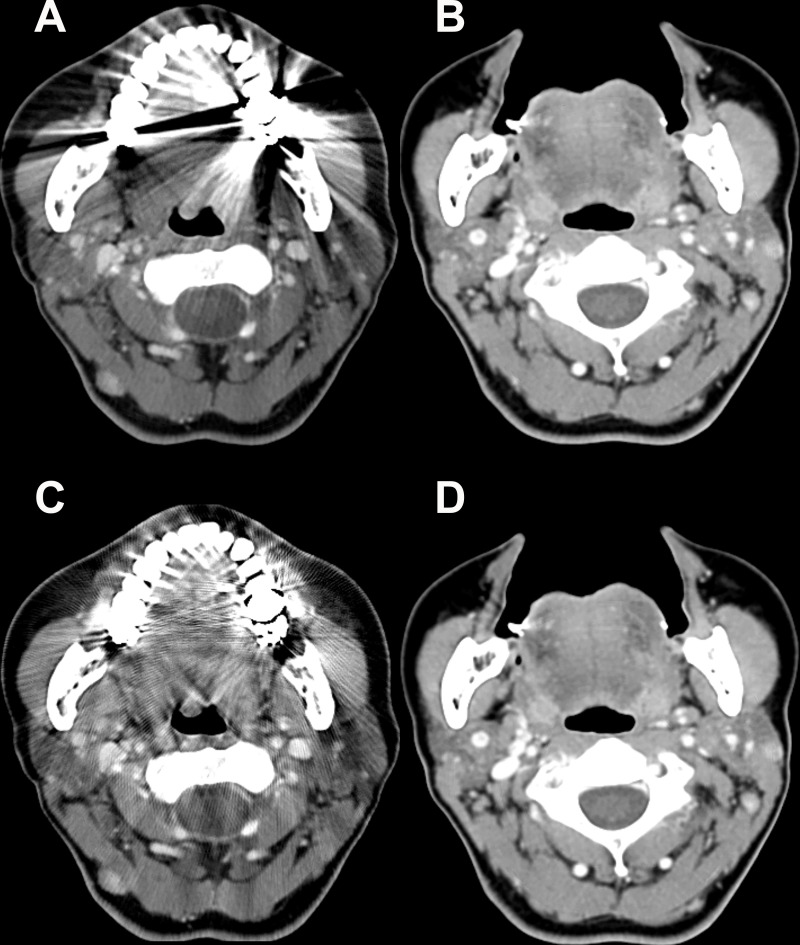
Post-contrast Computed Tomography (CT) images of a 56-year-old woman with a dental prosthesis.On the conventional CT image, the mobile tongue is barely seen due to the metallic artifact (A). However, the structure is clearly seen on the open mouth CT image (B), without overlapping dental prosthesis in the same imaging plane. (C) The additional application of O-MAR to conventional CT shows a substantial decrease in the extent of streak artifacts, but there are still remaining streaks. (D) On open mouth CT images with O-MAR processing, the added effect of O-MAR is not noticeable, since the streak artifact is already displaced from the open mouth maneuver. O-MAR = metal artifact reduction for orthopedic implants.